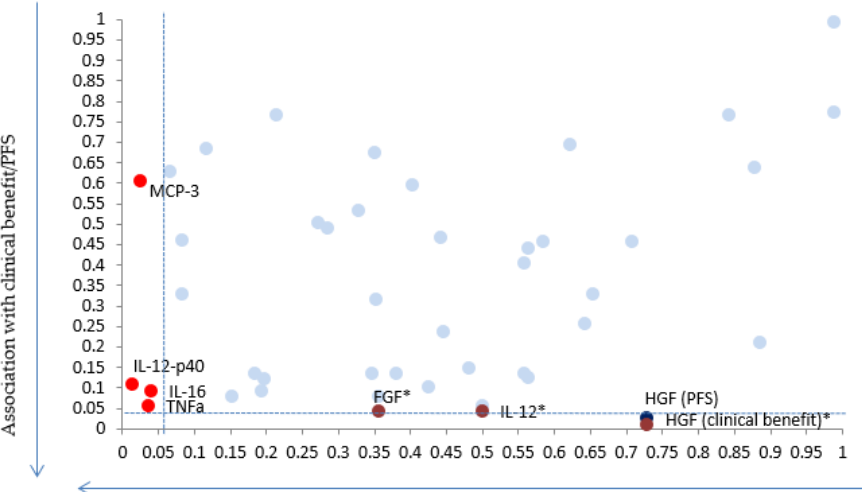
Figure 1. Scatter plot showing p -values for the 48 chemokines and cytokines with regards to grade 3–4 immune adverse events (irAEs) ( x axis) and Progression Free Survival (PFS) or clinical benefit ( y axis). * Indicates biomarkers for which results remain significant after applying correction for multiple testing.